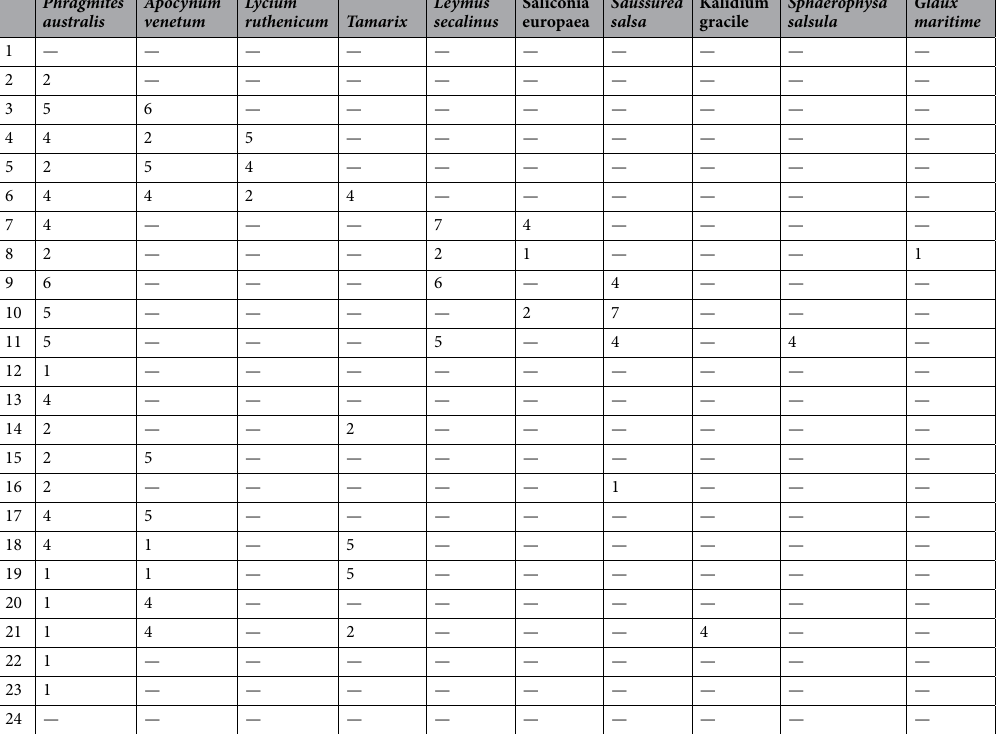
Table 1. Coverage of 10 species from 24 quadrats taken in the Tuanjie Lake salt marshes. Notes: Cover scale:— indicates 0% cover; 1 indicates < 1% cover; 2 indicates 1–5% cover; 3 indicates 5% cover; 4 indicates 5–12.5% cover; 5 indicates 12.5–25% cover; 6 indicates 25–50% cover; 7 indicates 50–75% cover; 8 indicates > 75% cover. Species coverage = π × (crown width/2) 2 ×